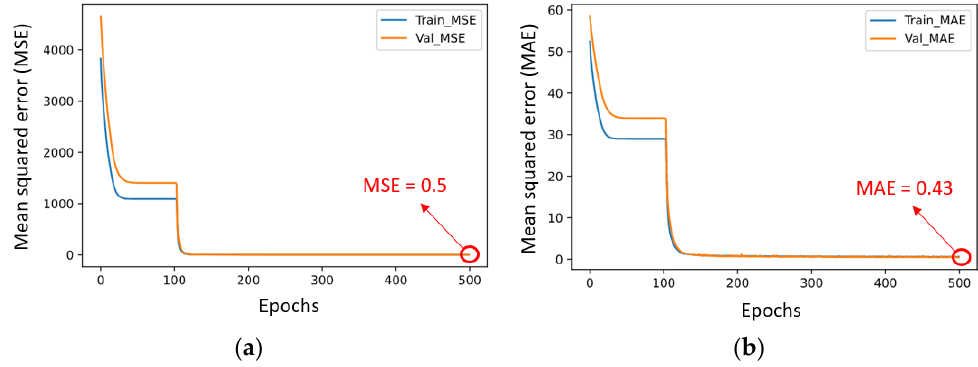
Figure 4. Training performances of the ANN: ( a ) Mean squared error (MSE); and ( b ) Mean absolute error (MAE).